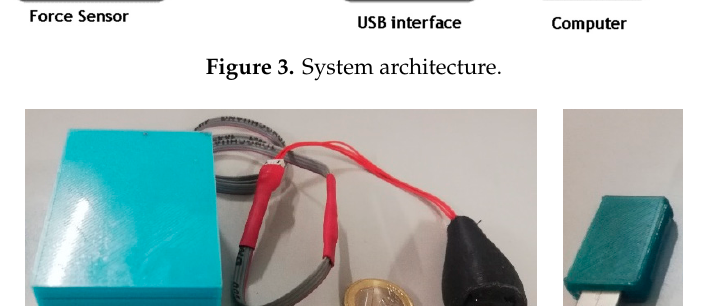
Figure 3. System architecture.